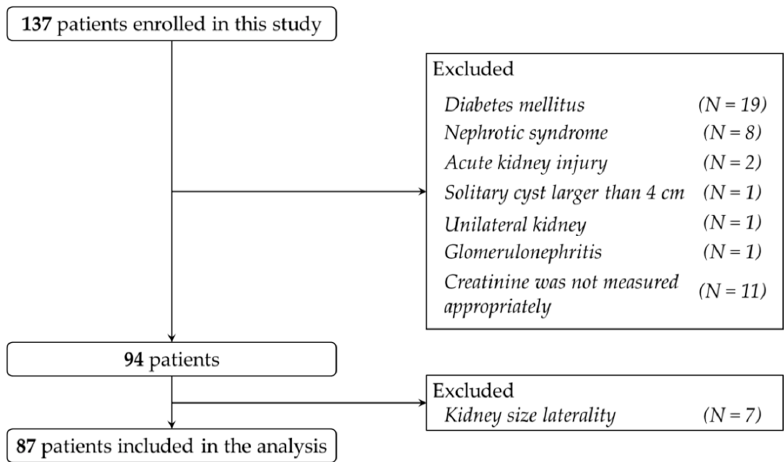
Figure 1. Study design. Of the 137 patients who underwent abdominal ultrasonography, 87 were included in the analysis.